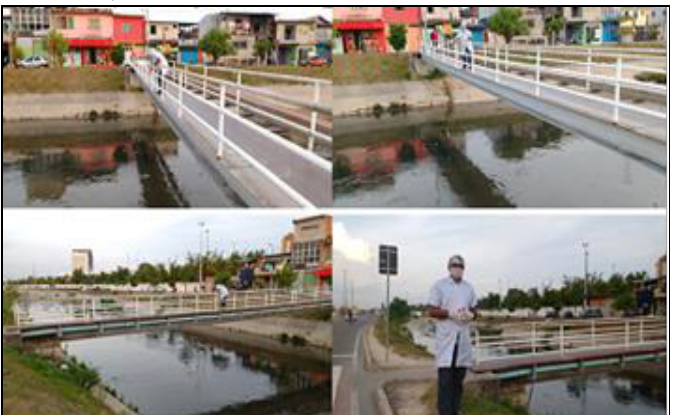
Figura 6: Igarapé do quarenta próximo ao Shopping Studio 5 Mall. Fonte: Autores, (2018).